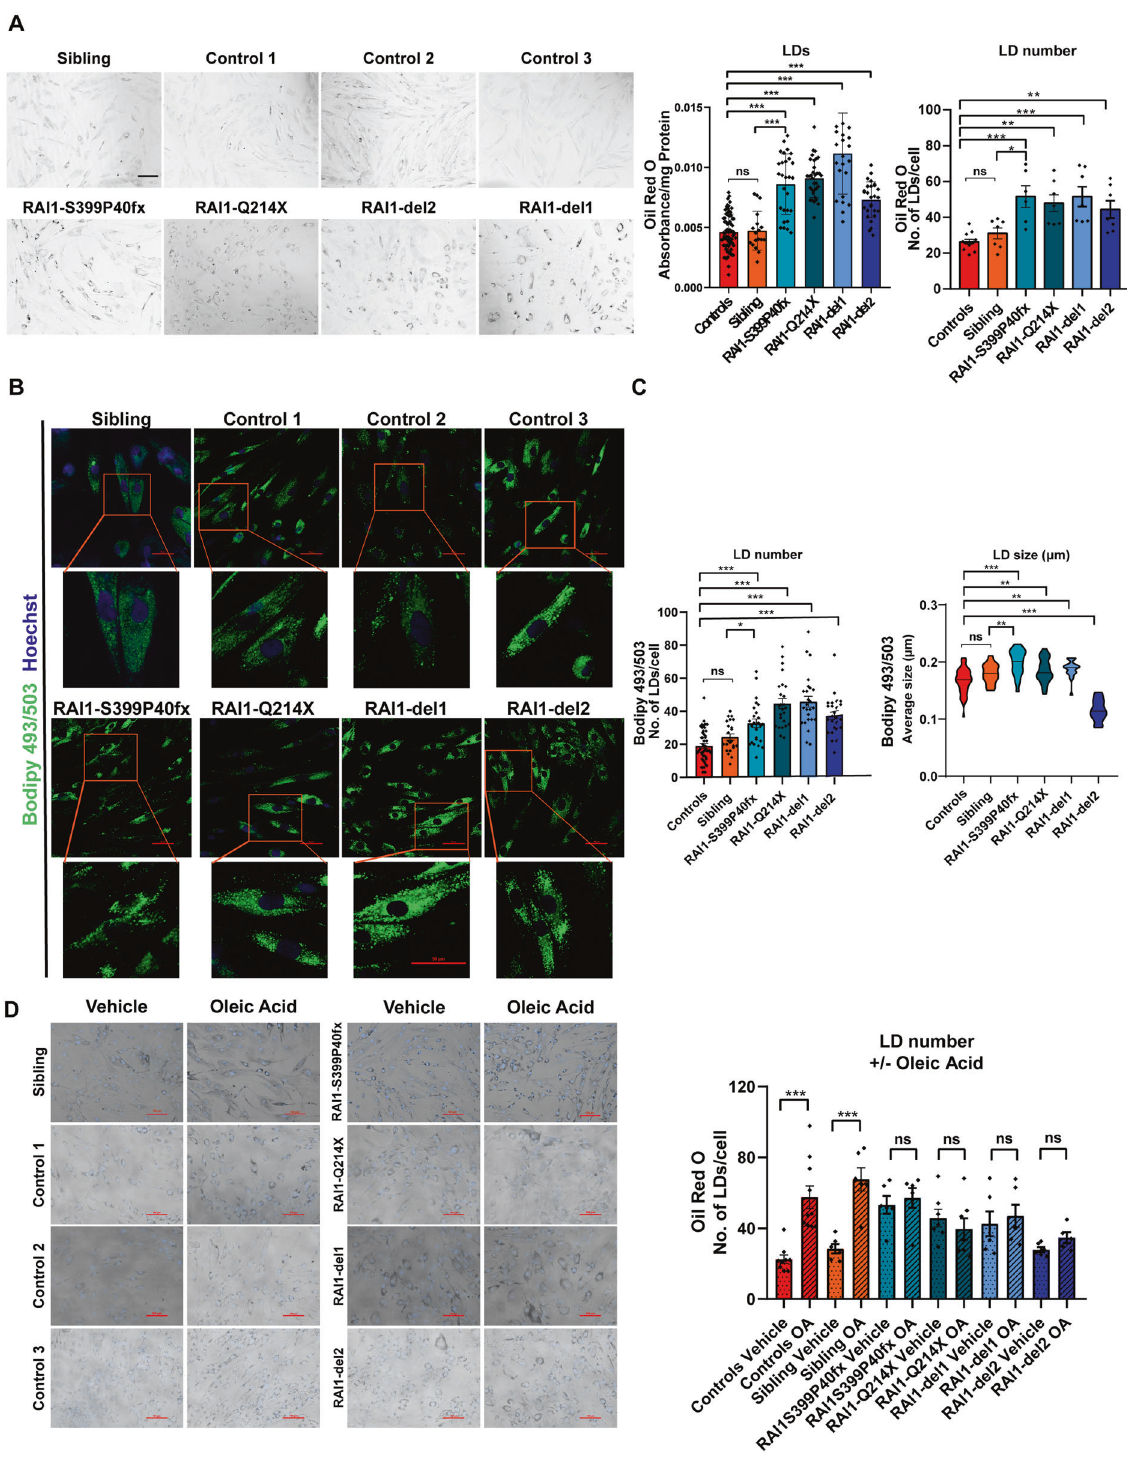
Fig. 4 Accumulation of lipid droplets in SMS patient-derived cells. A Left panel: Representative fl uorescence microscopy images of lipid droplets (LDs) colored with Oil Red O in SMS and CTR cells ( n = 5 biological replicates). Middle panel: Quanti fi cation of the optical density of nine independent wells from fi ve biological replicates. Right panel: Quanti fi cation of the number of LDs per cell among 150 cells from three biological replicates. B , C BODIPY staining analysis of the number and size of LDs in SMS and CTR cells. Left panel: Representative images of 10 fi elds from three biological replicates. Middle panel: Quanti fi cation of the LD number of 10 cells from 10 randomly selected fi elds from three independent experiments of each cell line. Right panel: Quanti fi cation of the size of LDs per cell among 10 cells from 10 randomly selected fi elds from three independent experiments of each cell line. D Oil Red O staining in four SMS and four CTR cell lines treated with vehicle and oleic acid (OA, 50 μ M, 48h). Left panel: Representative images. Right panel: Quanti fi cation of the number of LDs per cell among 150 cells from three biological replicates. Graphs: mean ±SEM, one-way ANOVA + Newman – Keuls post hoc test, * p <0.05, ** p <0.01, *** p <0.001, ns not signi fi cant.